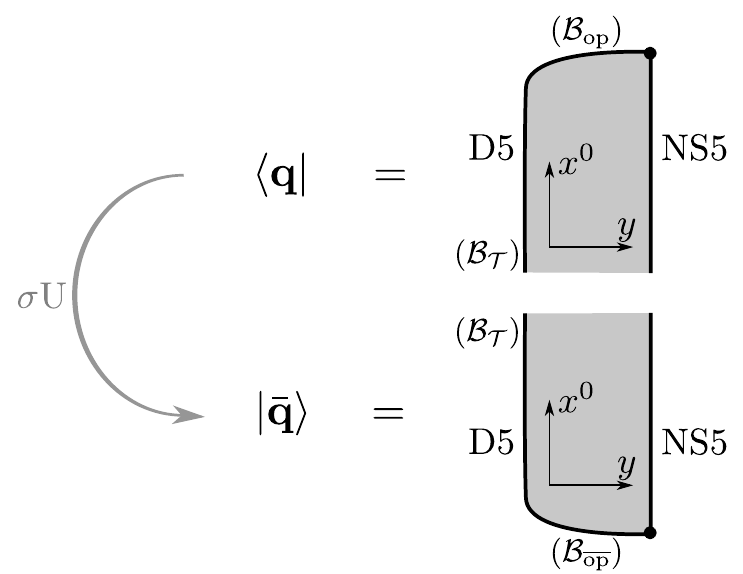
Figure 12 . Hermitian conjugation in topological theory is realizaed by operator (cid:27)U . It transforms the state h q j into j q i , as shown. Gluing these two states together gives the Liouville partition